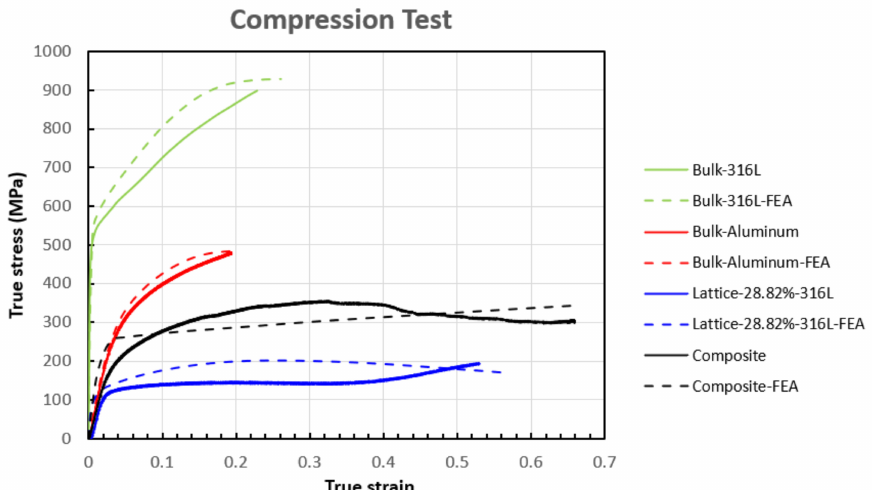
Figure 15. Comparison between experimental and FEA results of bulk 316L stainless steel, bulk dissolvable aluminum 316L stainless steel lattice, and 316L stainless steel/dissolvable aluminum composite for the compression test.